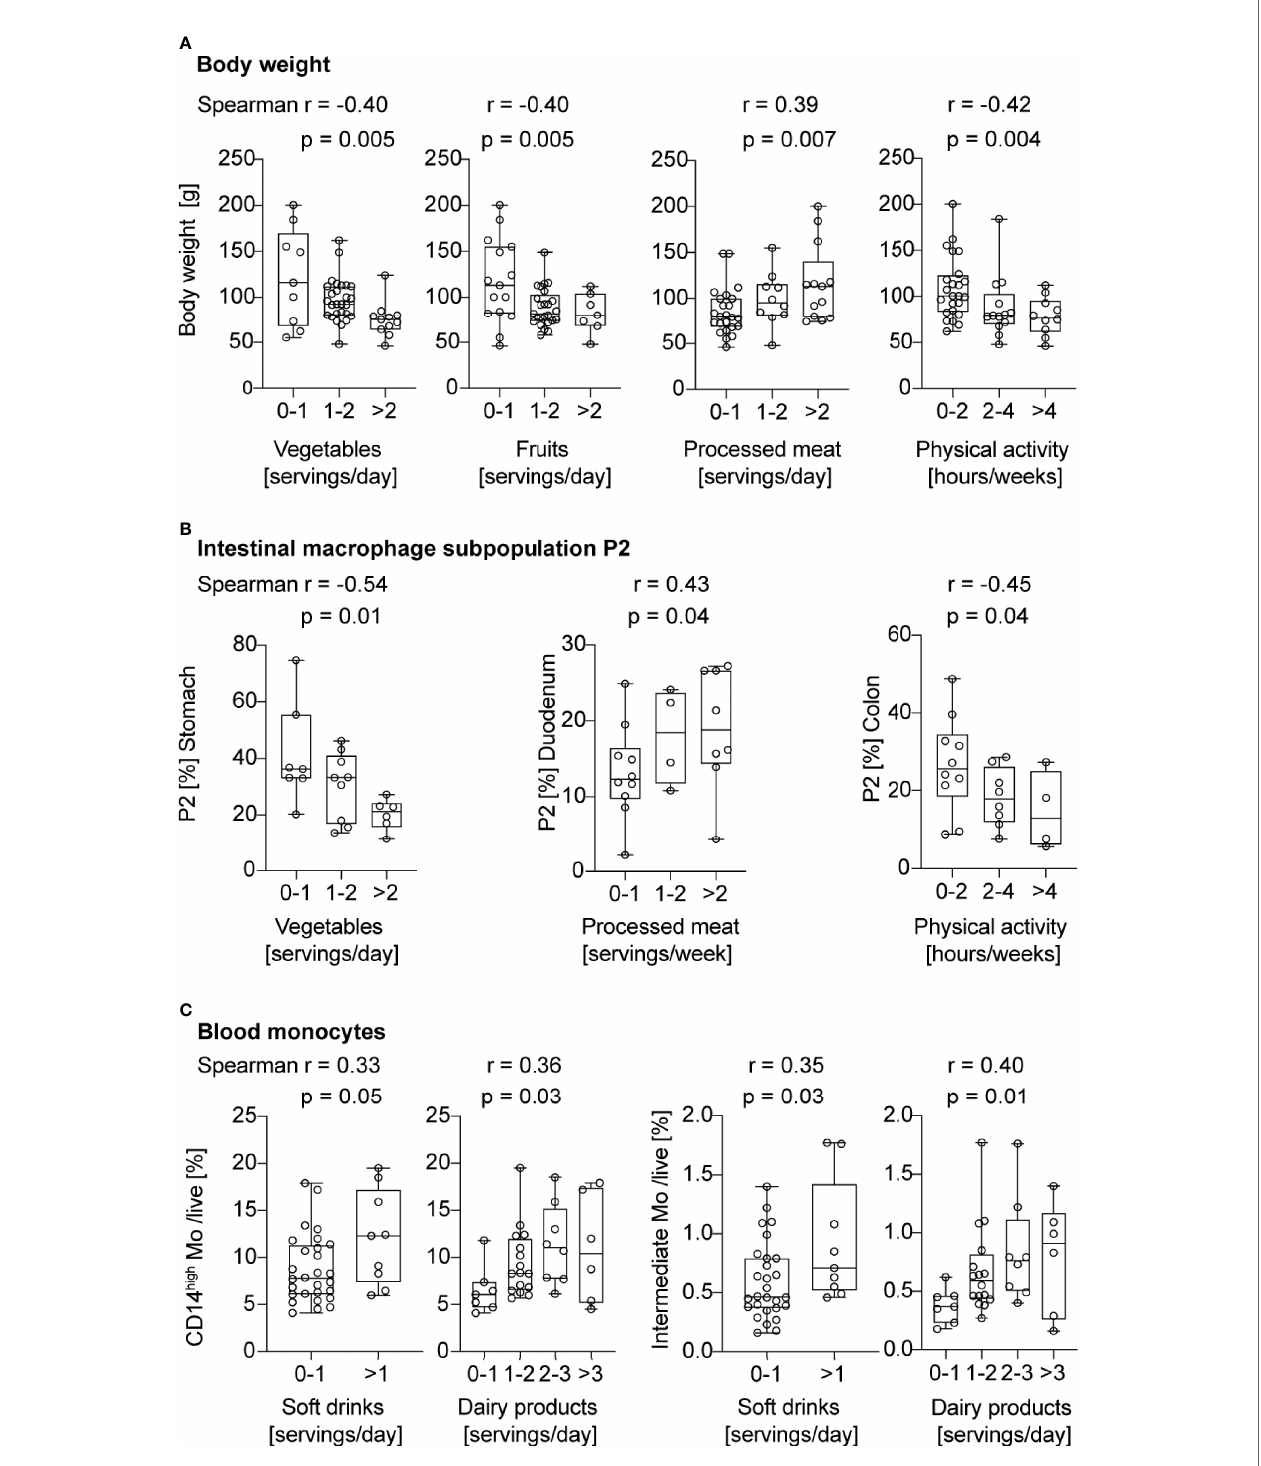
FIGURE 4 | Pro-in fl ammatory macrophage subpopulation P2 and intermediate blood monocytes correlate with unhealthy lifestyle habits. (A) Spearman correlation between servings of vegetables, fruits, processed meat, or hours of physical activity and body weight. (B) Spearman correlation between servings of vegetables, processed meat, or hours of physical activity and the portion of intestinal macrophage subpopulation P2. (C) Spearman correlation between servings of soft drinks or dairy products, and CD14 high or intermediate blood monocytes. One data point represents one subject. For statistical analysis, Spearman correlation analysis was performed, and p -values < 0.05 were considered signi fi